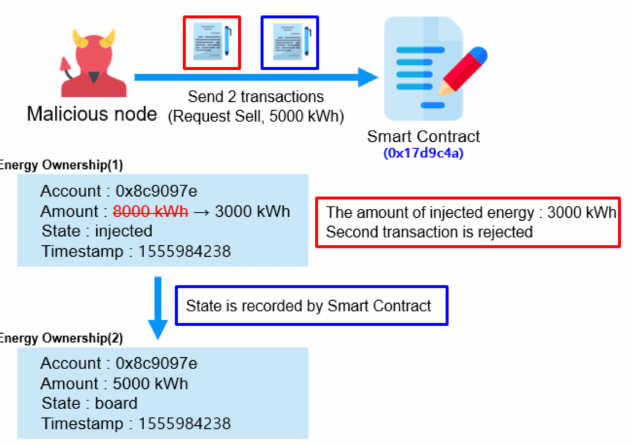
Figure 8. Prevent double sale by keeping the states of energy inside a smart